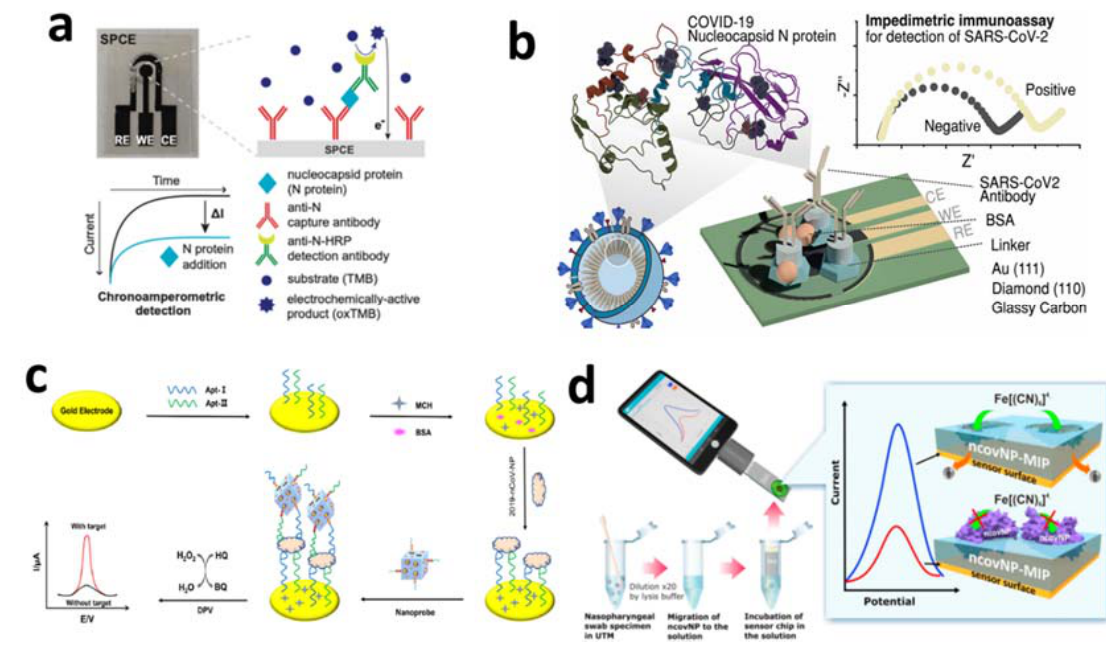
Figure 6. ( a ) Schematic illustration of the design and electrochemical responses of SCPE-based SARS-CoV-2 NP immunosensor (adapted with permission from ref. [89]). Copyright 2022 American Chemical Society. ( b ) Schematic illustration of the Au, GC, and BDD electrode-based EIS immunosensors for the detection of SARS-CoV-2 NP (adapted with permission from ref. [90]). Copyright 2022 Elsevier. ( c ) Schematic illustration of the development of aptasensor based on MIL-53(Al) decorated with Au@Pt NPs and enzymes for SARS- CoV-2 NP detection (adapted with permission from ref. [96]). Copyright 2021 Elsevier. ( d ) Schematic illustration of label-free MIP-based detection of SARS- CoV-2 NP (reprinted with permission from ref. [100]). Copyright 2021 Elsevier.